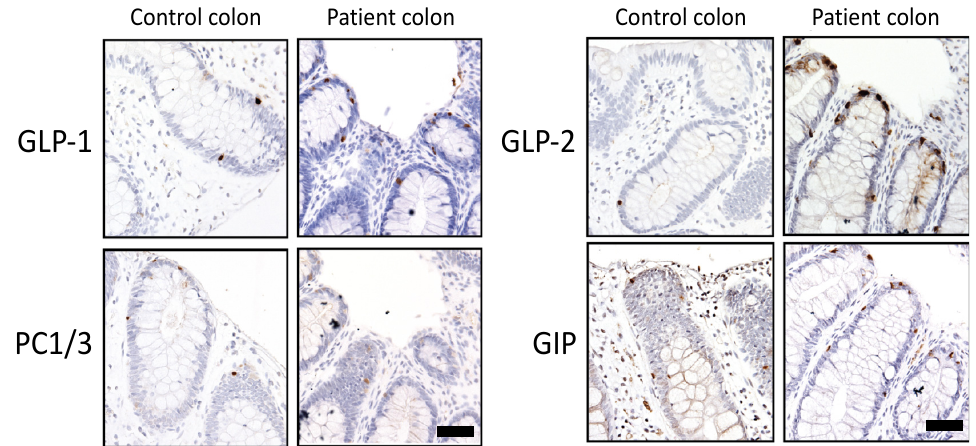
Figure 3. Immunohistochemical analysis of PC1/3 and gut hormones in colonic tissue. GLP-1: glucagon-like peptide 1; GLP-2: glucagon-like peptide 2; PC1/3: proprotein convertase 1/3; GIP: glucose-dependent insulinotropic polypeptide. Scale: 50 μ m.